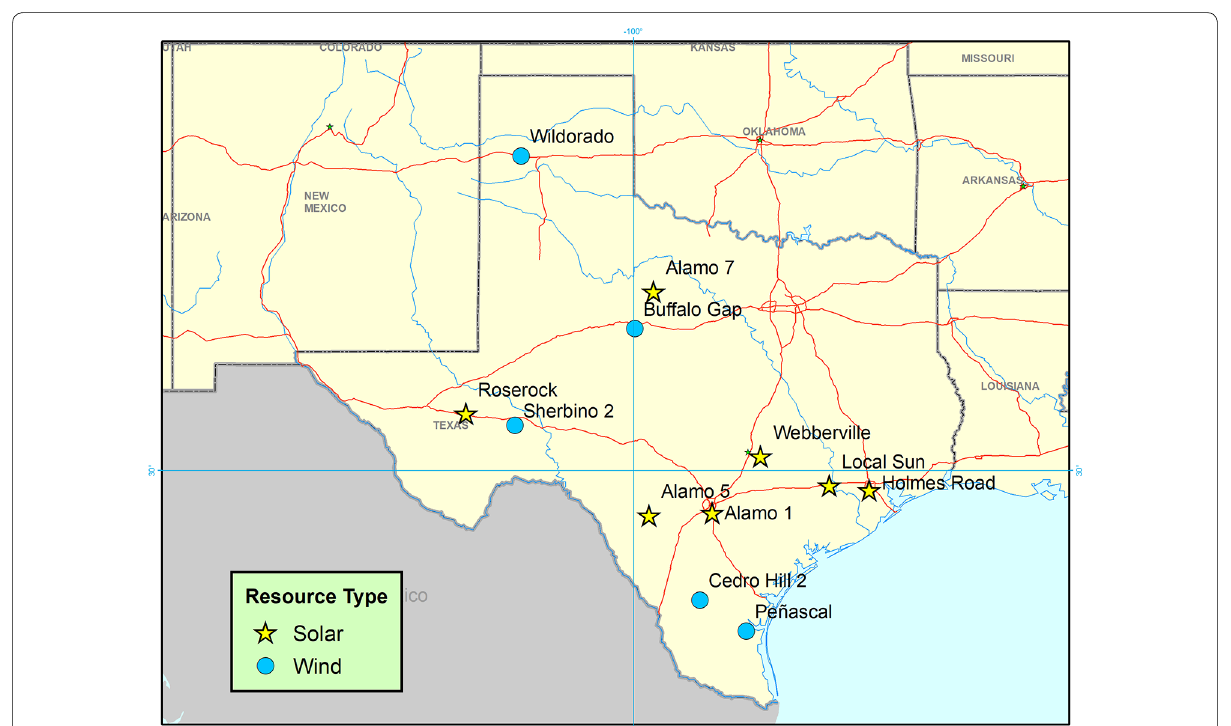
Fig. 1 The twelve sites selected for this study. Wildorado Ranch, Buffalo Gap, and Sherbino 2 are classified as “West Texas wind” and Cedro Hill 2 and Peñascal as “South Texas wind”